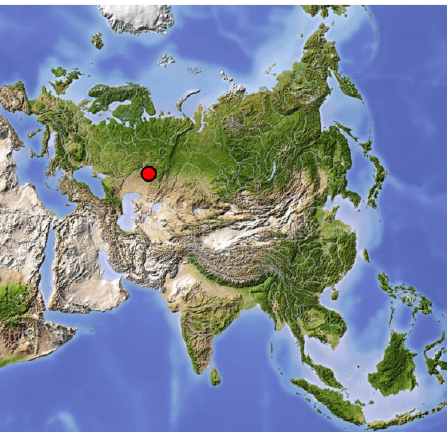
Figure 1. Location of the study site (red point) on the Eurasian continent. Table 1. Meteorological data in study area during research